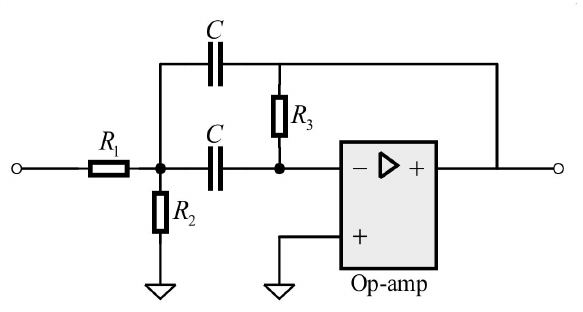
Figure 11. Multi-feedback band pass filter.